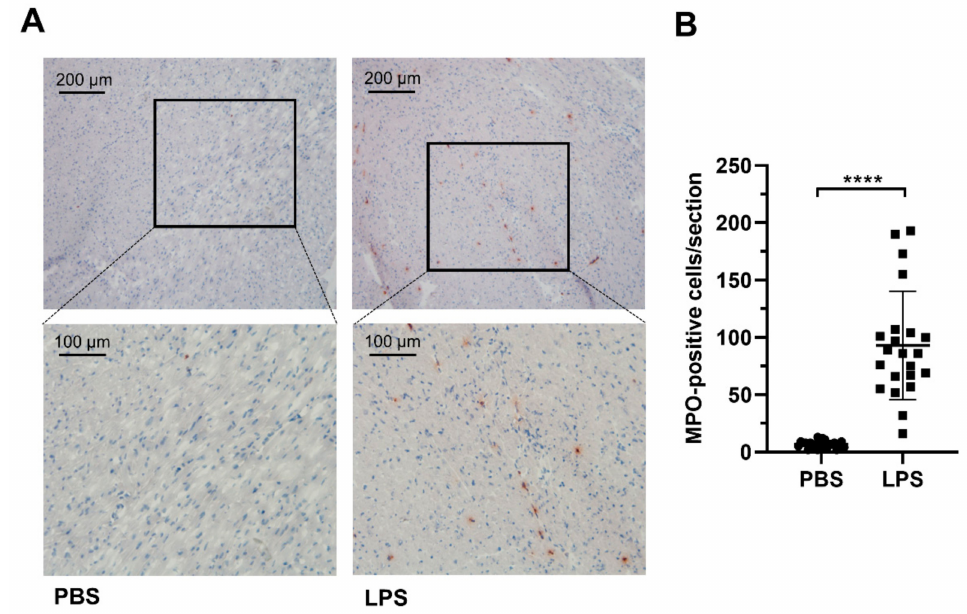
Figure 1. Immunohistochemical analysis of MPO expression in hearts of PBS- and LPS-treated mice. C57BL / 6 mice received a single i.p. injection of PBS (200 µ L) or LPS in PBS (from Escherichia coli , 0111:B4 in PBS, 8 µ g / g body weight) and were sacrificed 12 h after the injection. ( A ) Representative MPO-immunostainings of hearts isolated from PBS- and LPS-injected animals are shown at low and high magnification. ( B ) Statistical evaluation of MPO-positive cells in the sections of the hearts of PBS- or LPS-injected mice. Cryosections of eight di ff erent heart regions from PBS- or LPS-injected animals ( n = 3) were counted manually for MPO-positive cells. Lines indicate mean ± SD values. Unpaired student’s t -test; **** p ≤